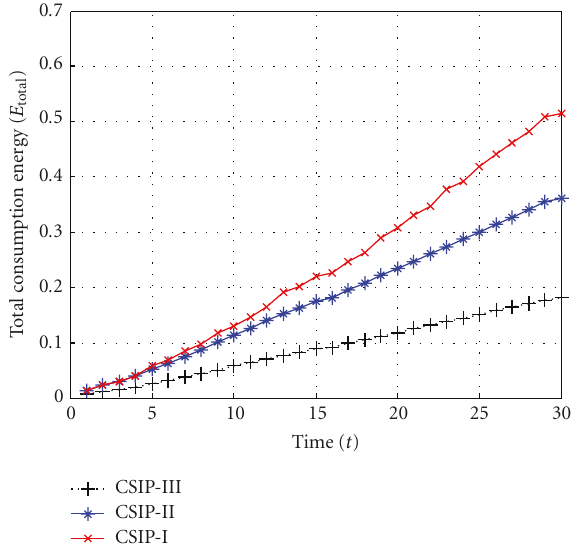
Figure 9: The cumulative communication energy consumptions of CSIP-1, CSIP-II, and CSIP-III after the entire trafcking process. x - axis unit: second; y -axis unit: Joule.